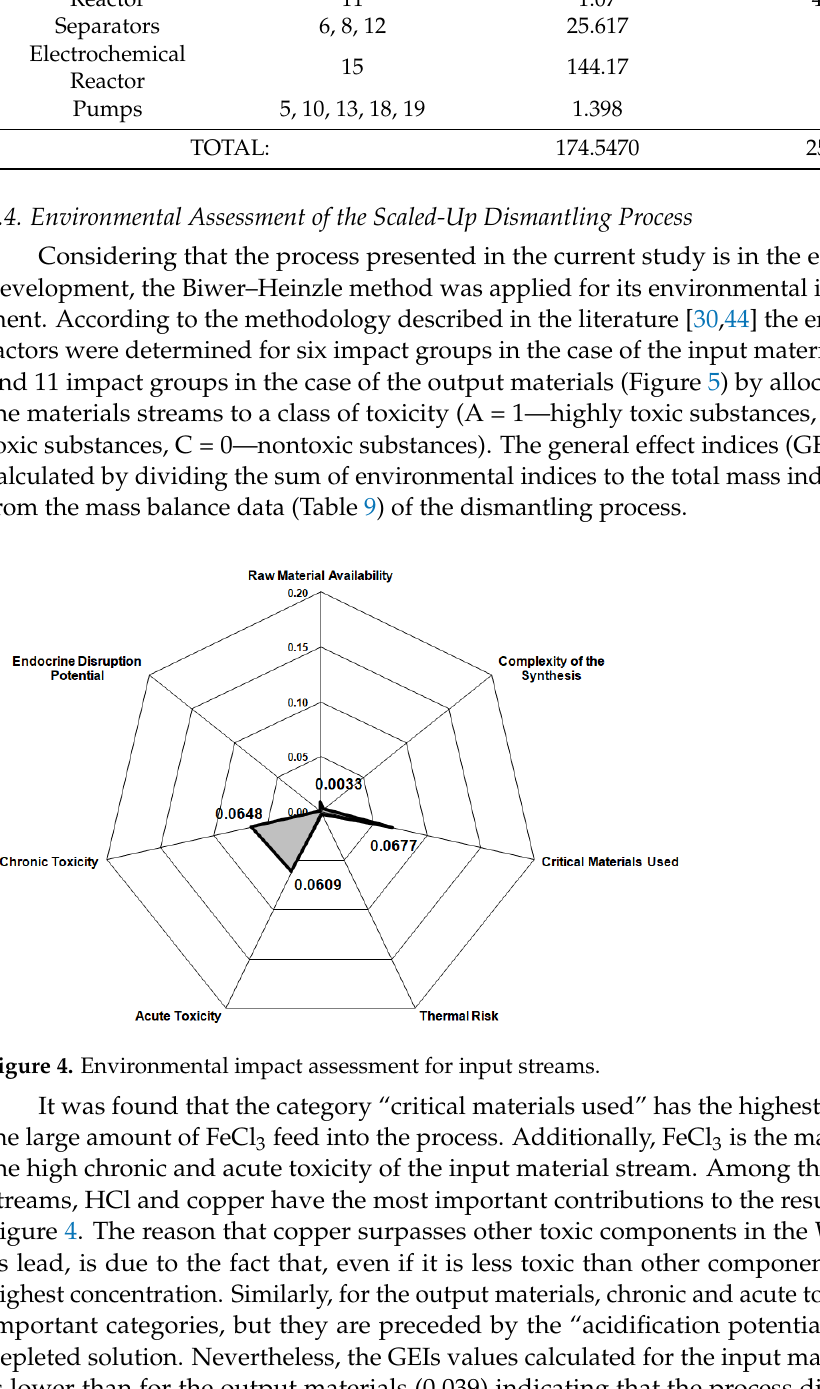
Table 11. Overall energy balance of the scaled-up dismantling process.